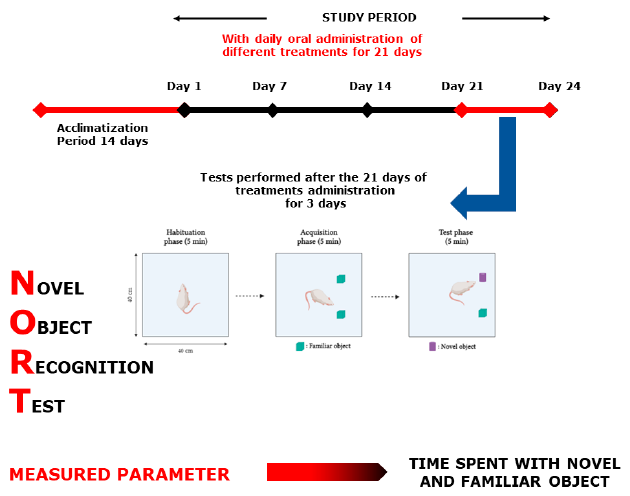
Figure 14. Novel Object Recognition Test scheme.